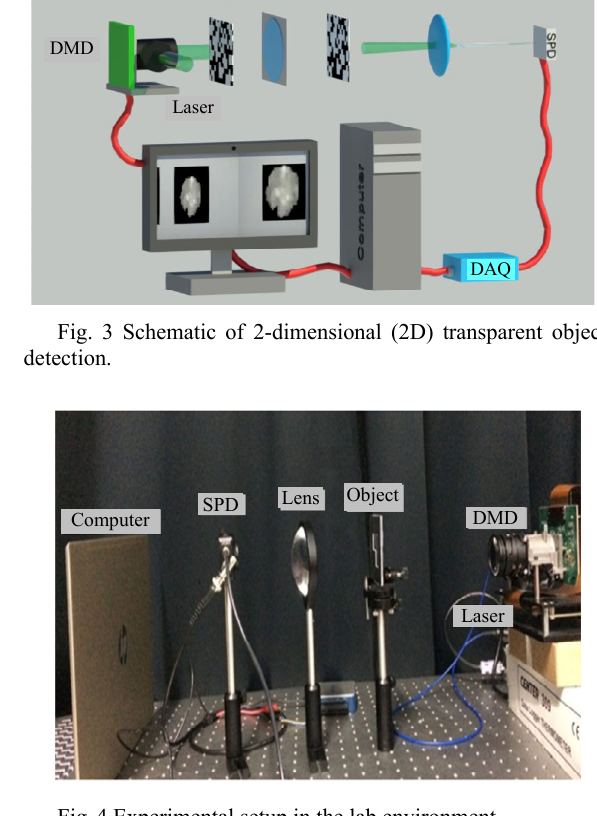
Fig. 4 Experimental setup in the lab